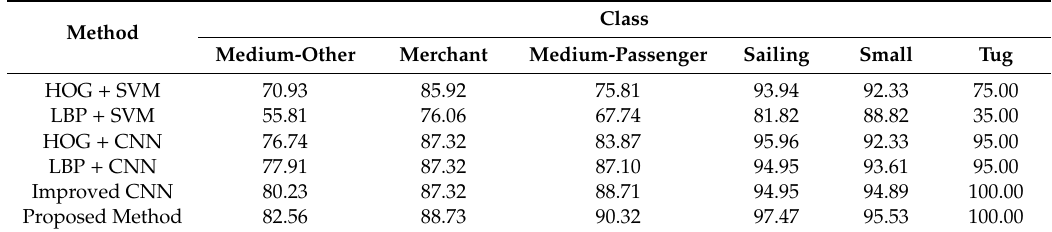
Table 10. Class-specific accuracy (%) of di ff erent methods for the VAIS